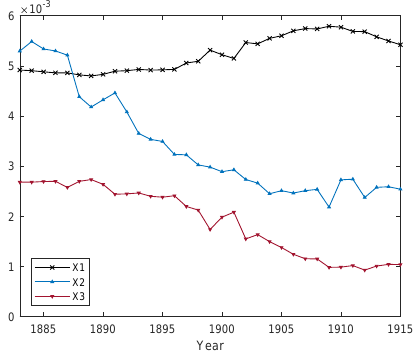
Figure 5. Factors in the CIR Model.